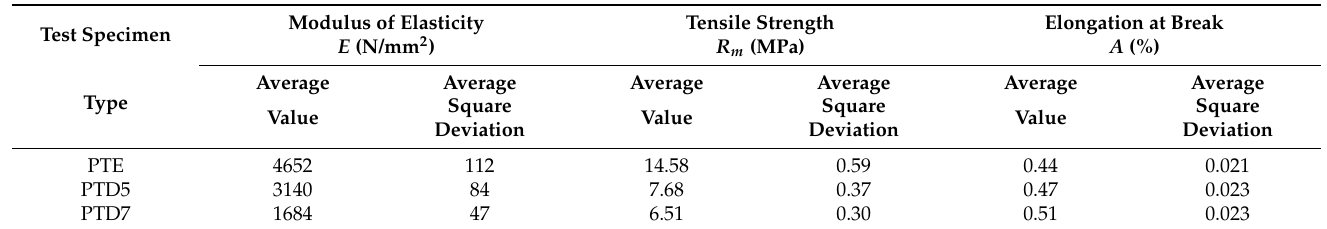
Table 3. Mean value and mean square deviation for modulus of elasticity, tensile strength and elongation at break for PTE, PTD5 and PTD7 specimens.